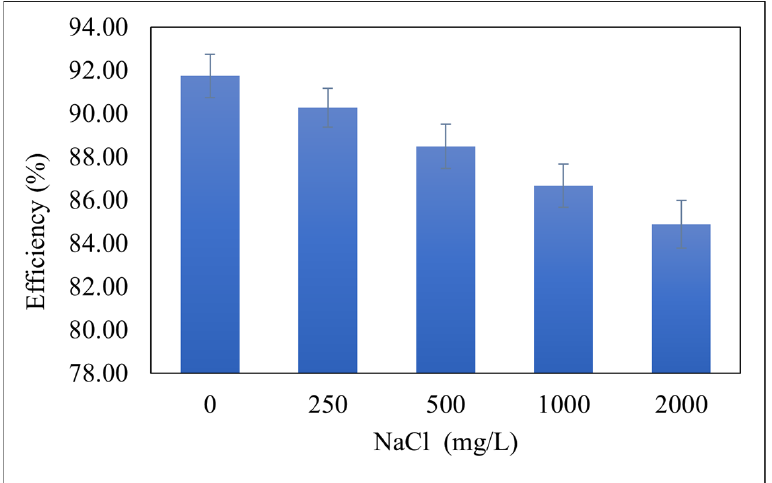
Figure 5. Effect of NaCl concentration on the removal efficiency of oil by IL4. Initial oil concentration = 500 mg/L, contact time = 4 min, pH = 8 phase ratio (PW:IL) = 4:1 and temperature = 25 °C, with σ = ± 3.37 × 10 − 1 %.